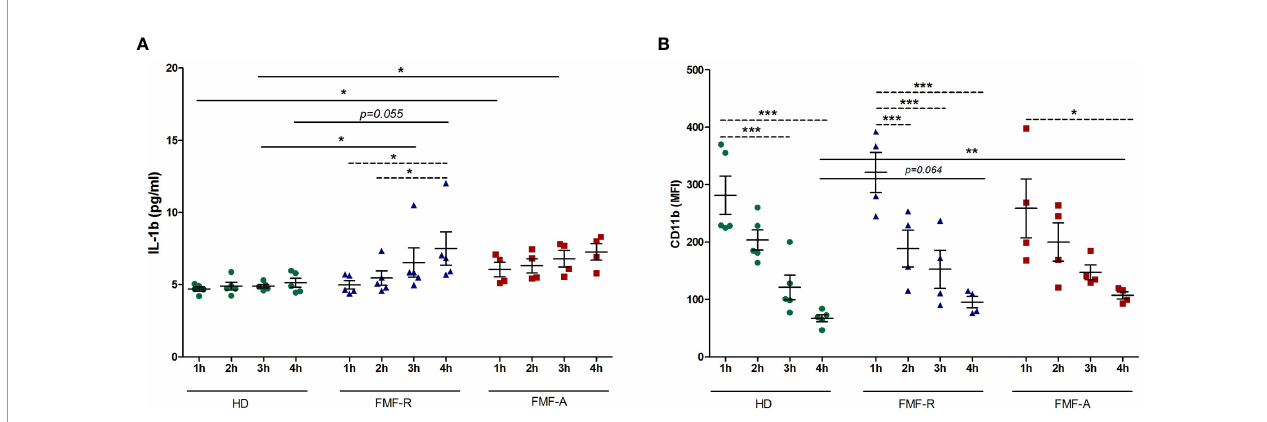
FIGURE 6 | Analysis of time-dependent kinetics of PMNs activation. The cells were isolated from HD, FMF-R and FMF-A patients and cultured for 1h, 2h, 3h and 4h in induction-free media. After each cultivation period, PMNs and culture supernatants were analysed. (A) Production of IL-1 b in supernatants of cultured PMNs as assessed by ELISA; (B) Surface expression of CD11b (MFI) analysed by fl ow cytometry. * p < 0.05; ** p < 0.01; *** p < 0.001.